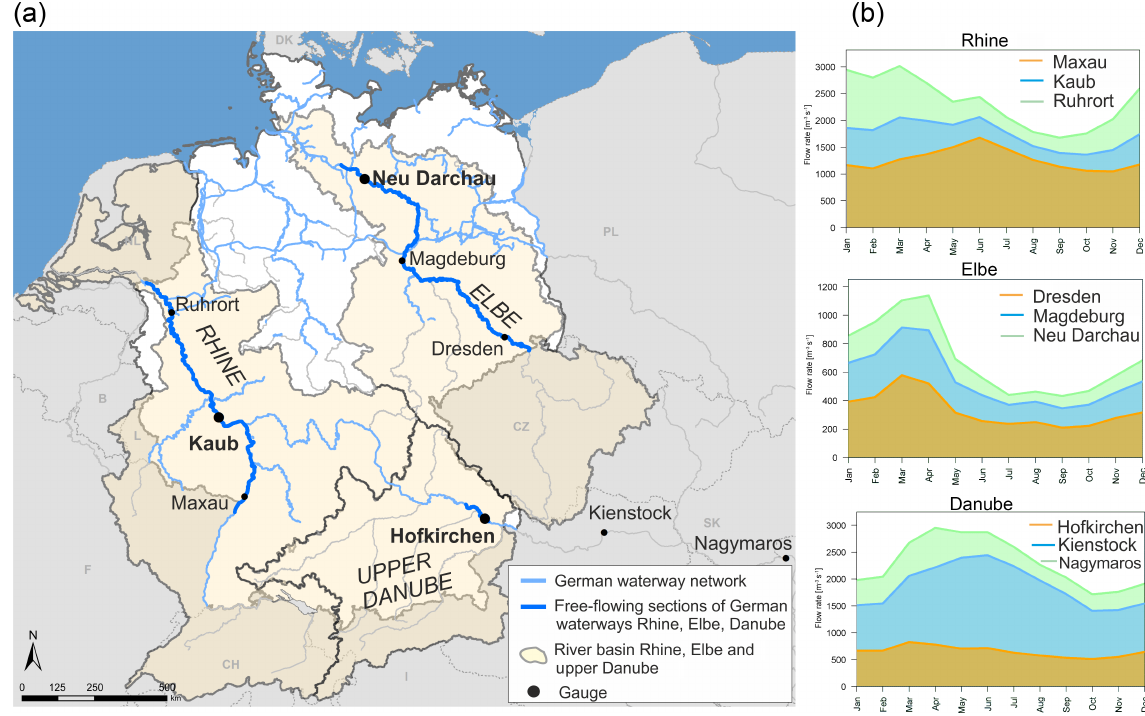
Figure 2. Map showing the German stretches of the international waterways the Rhine, Danube and Elbe (a) , for relevant gauges (black dots) the long-term monthly mean flow rates (1981–2000) are visualized (b)